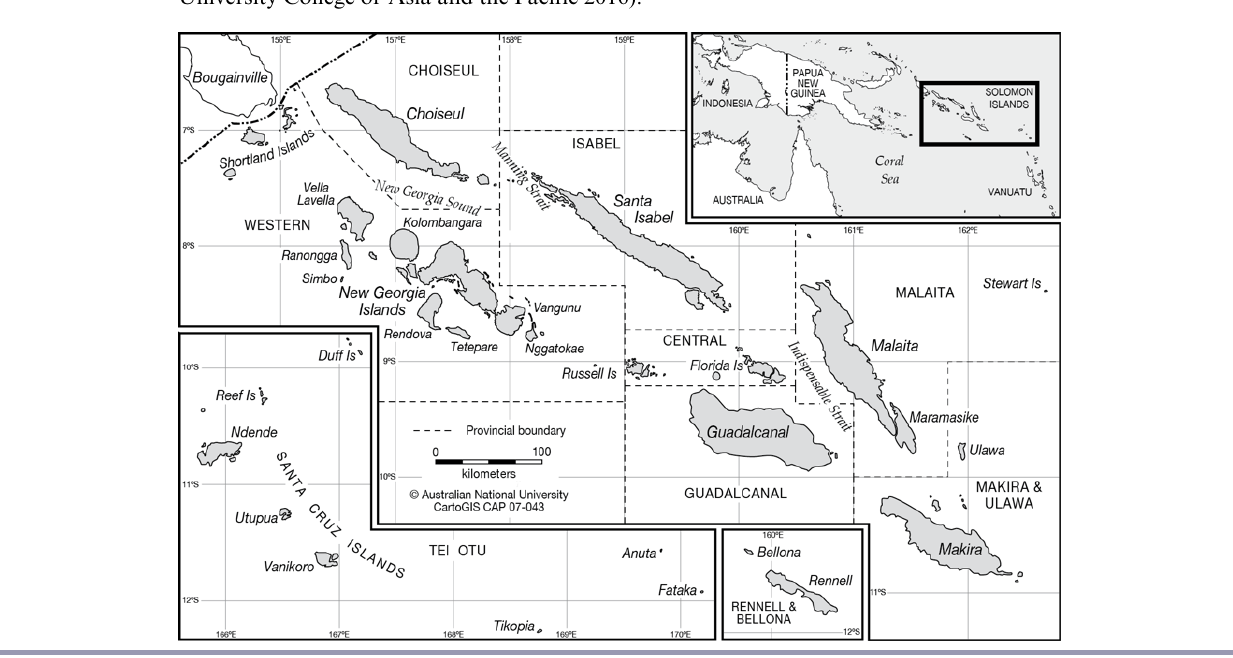
Fig. 1 . Solomon Islands showing current provincial boundaries. (Australian National University College of Asia and the Pacific